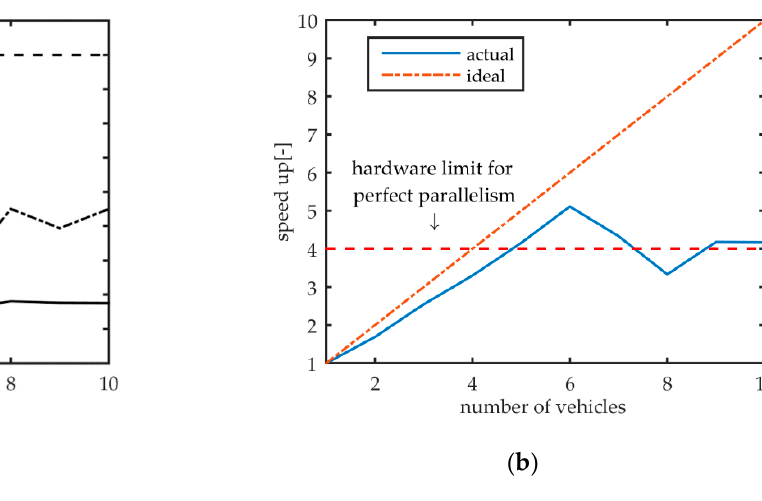
Figure 6. Simulator performances ( a ) and speed-up ( b ).